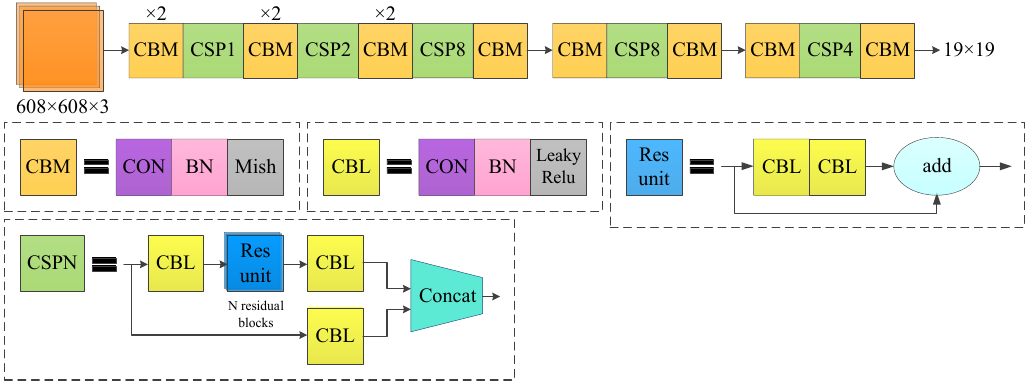
Figure 3. Network structure diagram of CSPDarknet-53.